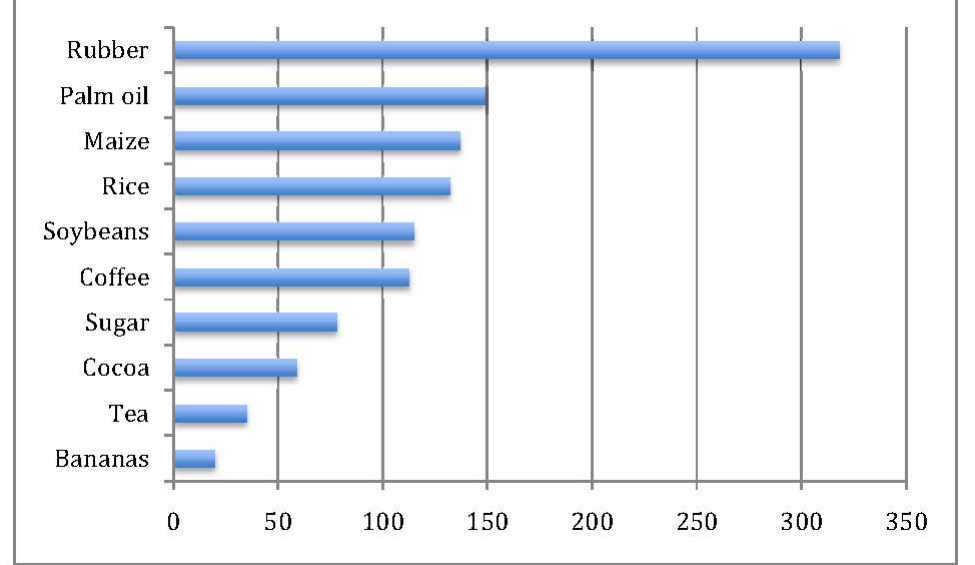
Figure 3. Percent increase in real export prices, 2001–2012. Source: